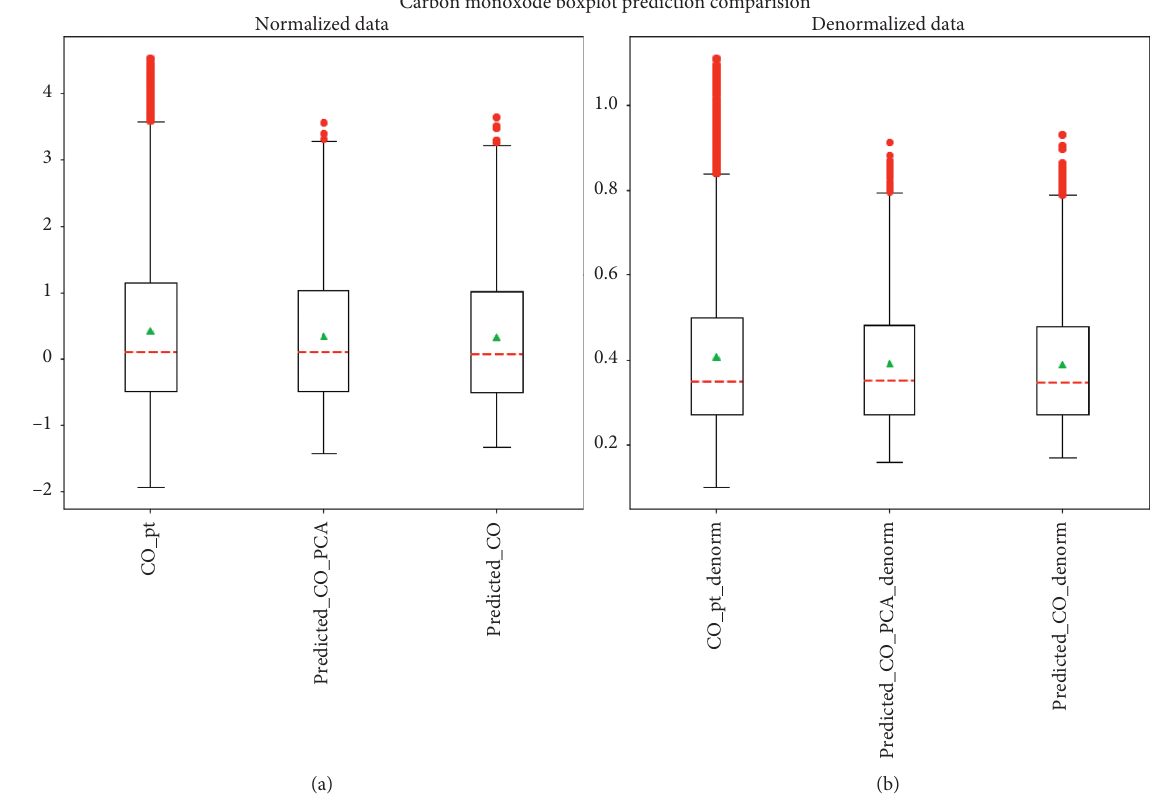
Figure 7: Boxplot of predicted and observed carbon monoxide values.